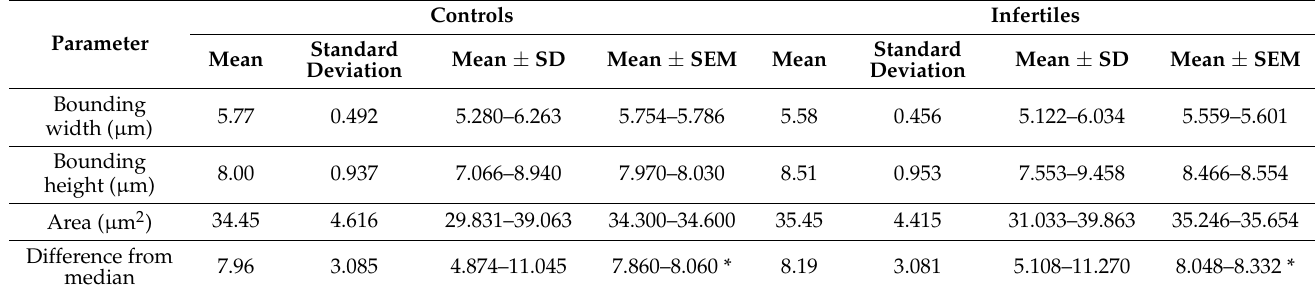
Figure 2. Consensus sperm nuclear shapes in control versus infertile males. The measurements that the infertile cohort nuclei are taller and thinner are further demonstrated by overlaying the consensus outlines (the ‘average’ shape) of the control (blue) and infertile nuclei (yellow) nuclei. Table 1. Sperm nuclear measurements in control versus infertile males. Mean values, standard deviations and standard error of the mean of the bounding widths, heights, areas and difference from median of the nuclei. * Denotes where the error bars overlap for the difference from median